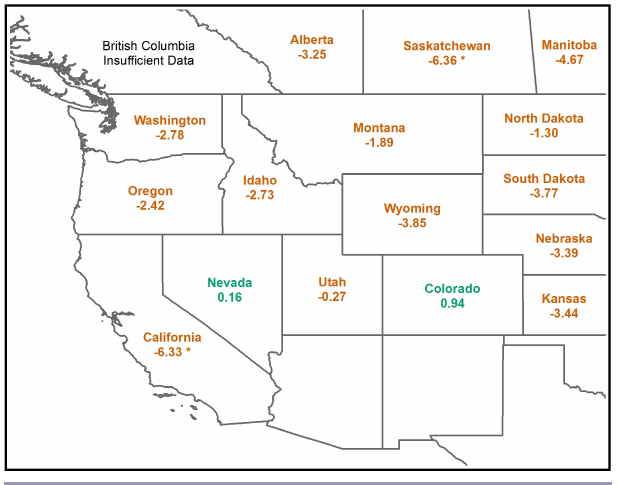
Fig. 1 . State and province estimated annual trends in Short- eared Owl ( Asio flammeus ) populations from 1966–2013 from the Breeding Bird Surveys within the United States and Canada (Sauer et al. 2014). California and Saskatchewan are the only samples whose 95% confidence interval failed to overlap